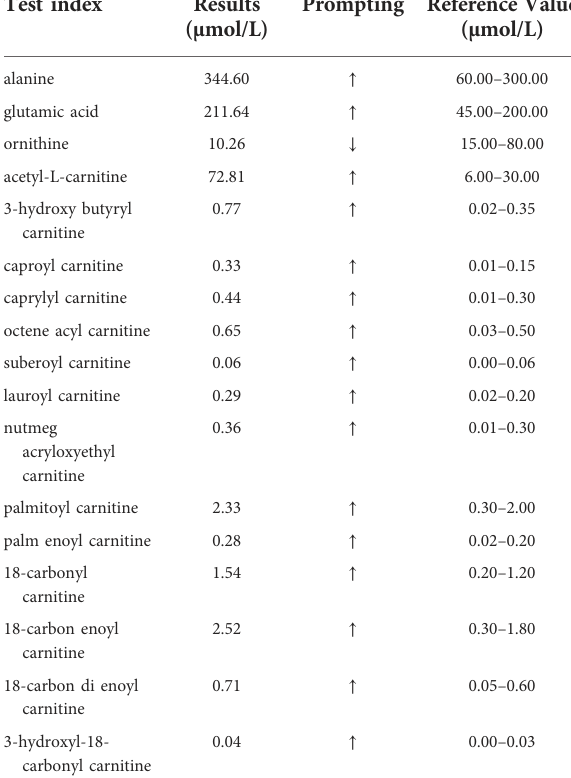
TABLE 1 Results of blood tandem mass